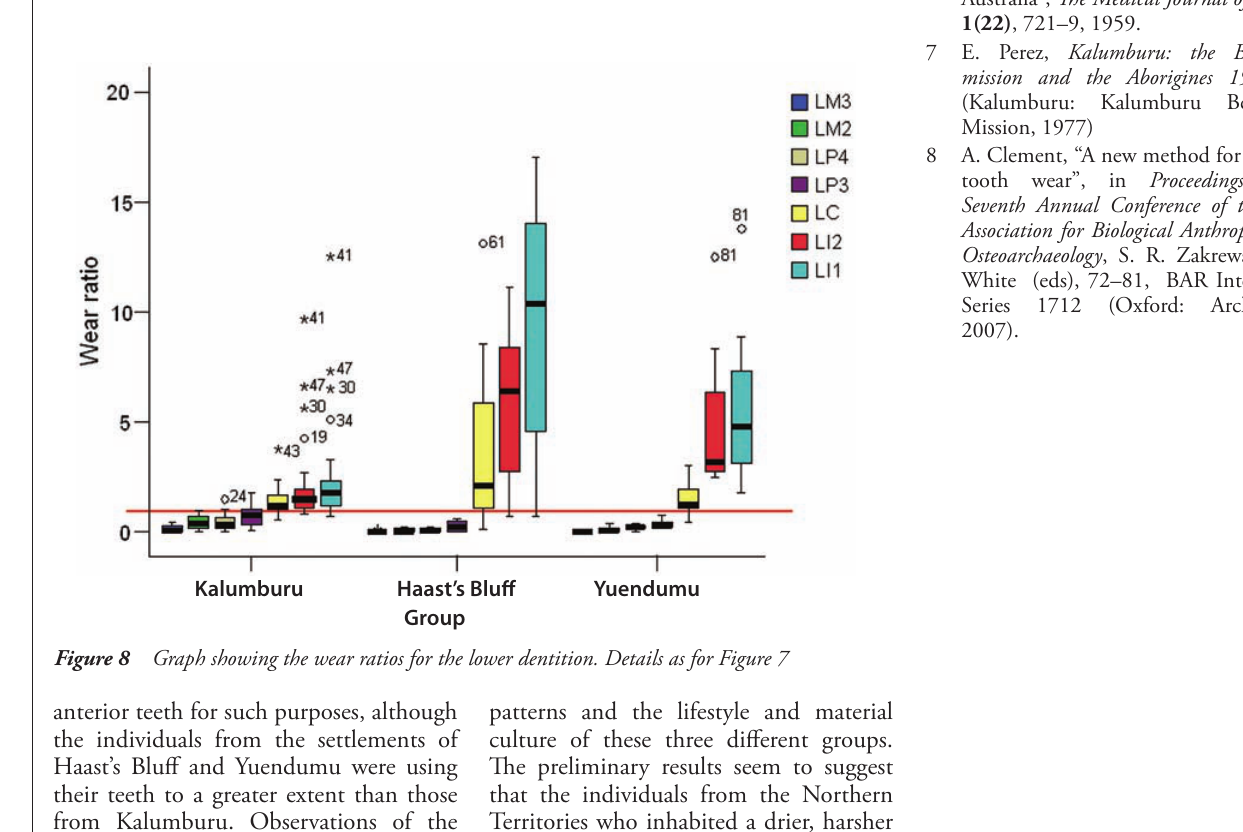
Figure 7 Graph showing the wear ratios for the upper dentition. Each box plot represents an individual tooth, starting with the third molar and following through to the first incisor; the first molar is not present as it is being used as the reference tooth. The y-axis represents the dentine proportion of each tooth, (as a ratio of the dentine proportion of the first molar), and the red line represents a wear ratio of 1:1 (i.e. the level of the first molar)